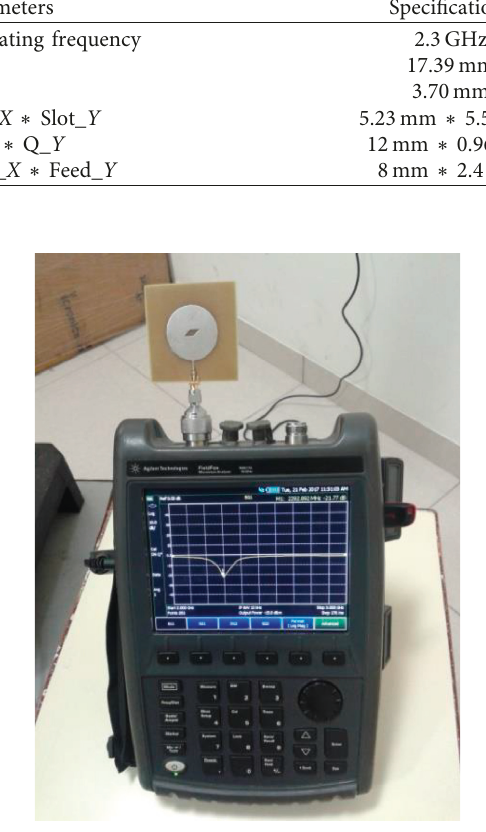
Figure 3: Testing of antenna.